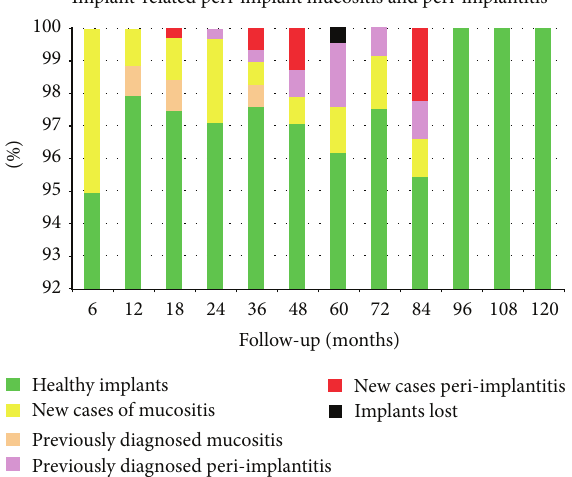
Figure 3: Implant related prevalence and incidence of peri-implant mucositis, peri-implantitis, and implants’ loss.